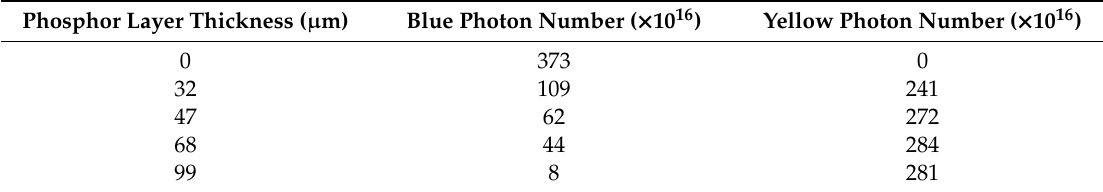
Table 2. Calculated photon numbers for di ff erent LED phosphor layer thicknesses.